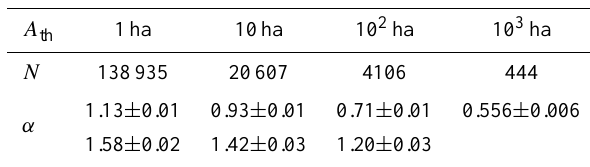
Table 1. Number ( N ) and scaling exponent ( α ) of fire sequences with burnt area ( A ) above or equal a given burnt area threshold ( A th ), N(A ≥ A th ), for increasing values of the threshold A th . Re- garding the scaling exponent, the first value corresponds to the in- termediate timescale range, the second value to the higher timescale